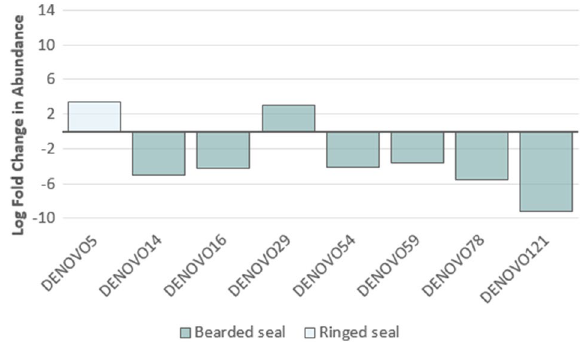
Figure 3. Log fold differential change in OTU abundance of polar bears demonstrating low levels of dietary bearded seal or ringed seal compared to those that demonstrated high levels. Dietary proportion was considered ‘high’ if the measurement detected was above or equal to the median across samples, and ‘low’ if below the median. Taxonomic information related to each OTU is given in Table 1.